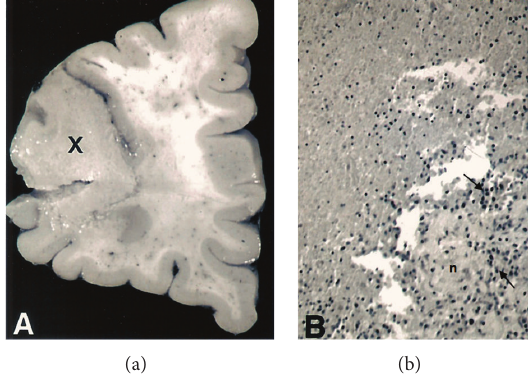
Figure 2: (a) Macroscopic view of a vertical-transverse section of thefrontallobeofbrain.Aspaceoccupyinglesioninthebraincortex and white matter is marked as X. Note the presence of punctate haemorrhages in grey and white matter. (b) Microphotograph of a vertical-transverse section of the lesion in (a) showing the histologic aspect of the expansive nodule (X). Note the presence of necrosis (n) of white matter with a perilesional inflammatory component ( → ) (H/E, × 100).